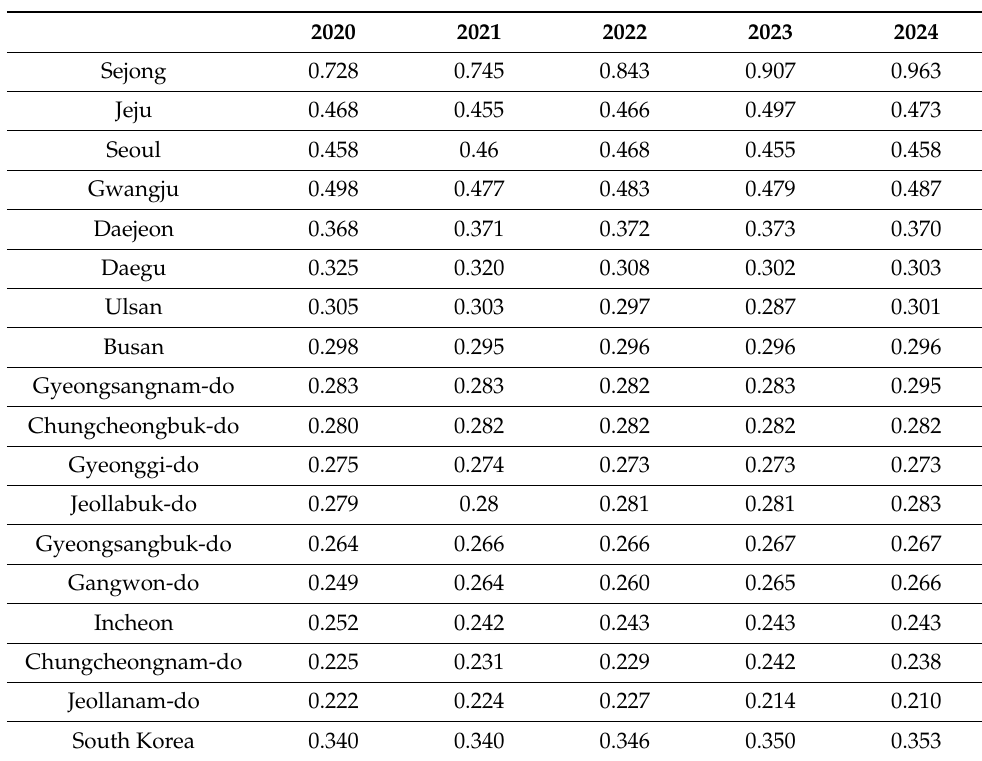
Table 11. Prediction results of the low-carbon economic efficiency value in South Korea